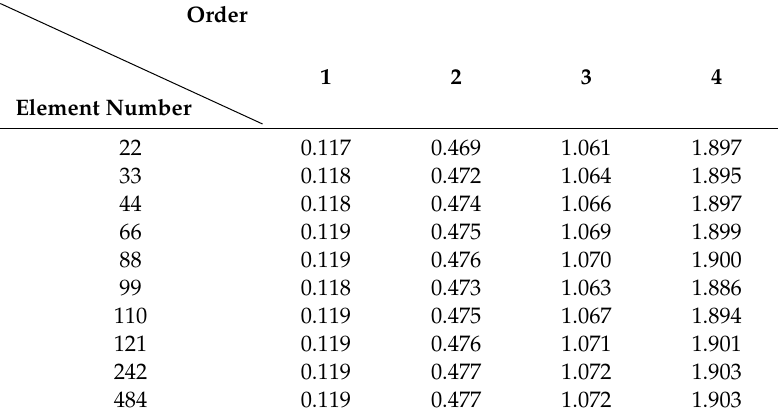
Table 9. Natural frequencies via spatial discretization ( h = 0).